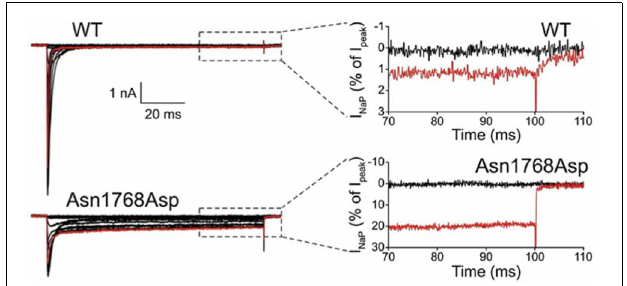
FIGURE 2 | Mutations of human SCN8A . The positions of twelve recently identified mutations of SCN8A are indicated on the backbone of the channel structure. The four homologous domains are labeled with the pore domains in green, the voltage-sensing transmembrane segments (S4) in blue, and the inactivation gate in red. Filled circles, mutations identified in patients with epilepsy. Open circles, mutations identified in patients with cognitive deficits. Unpublished mutations are shown in their approximate